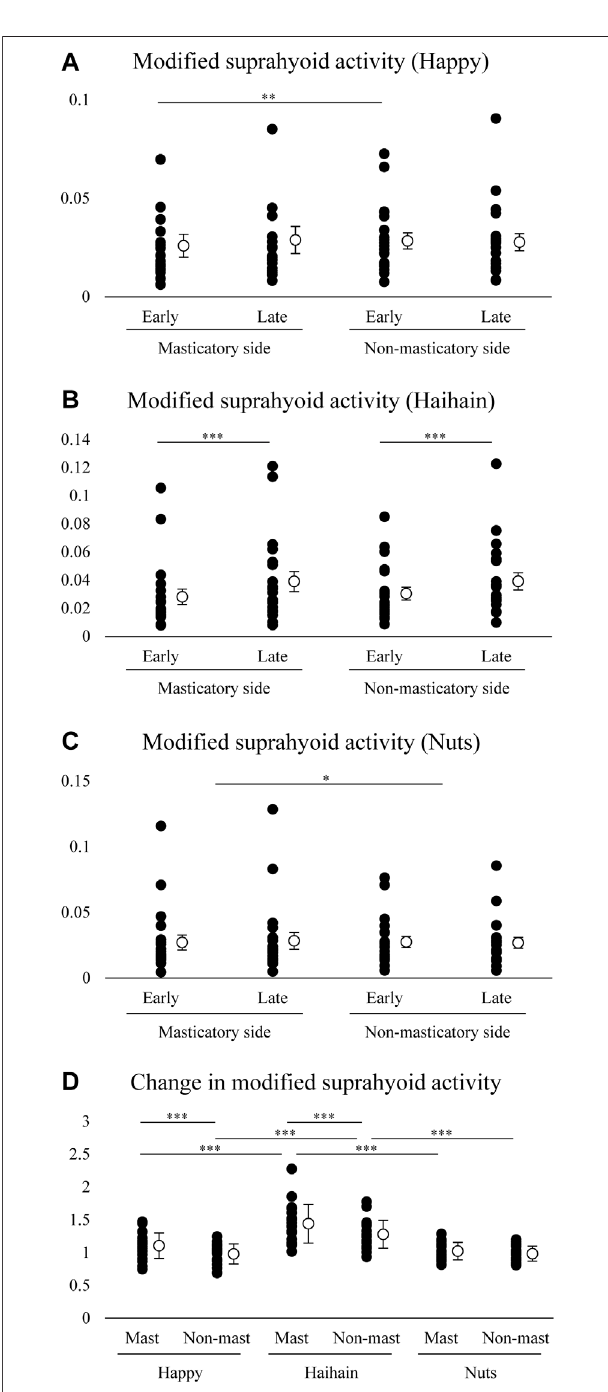
FIGURE 9 | Modi fi ed suprahyoid activity and changes in modi fi ed suprahyoid activity. Open circles indicate mean values. Modi fi ed suprahyoid activity was de fi ned as suprahyoid electromyographic activity divided by maximal vertical jaw distance per masticatory cycle. There was no signi fi cant difference between early and late stages on both sides during Happy (A) and Nuts (C) mastication but during Haihain mastication (B) . Side effect, p =0.017;Food ×Stageeffect, p =0.019for A.Stageeffect, p < 0.001 for B. Side effect, p = 0.034 for C. (D) Increasing rate of modi fi ed suprahyoid activity was signi fi cantly higher on both the masticatory (Mast) and non- ( Continued